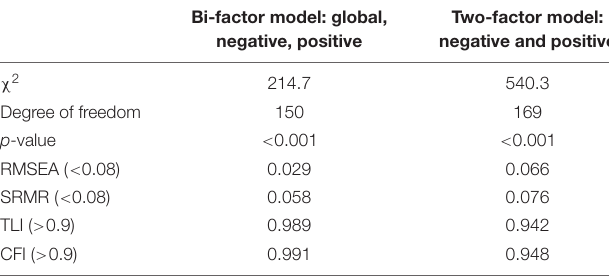
TABLE 2 | Fit statistics from confirmatory factor analytic models. Bi-factor model: global, Two-factor model: negative, positive negative and positive